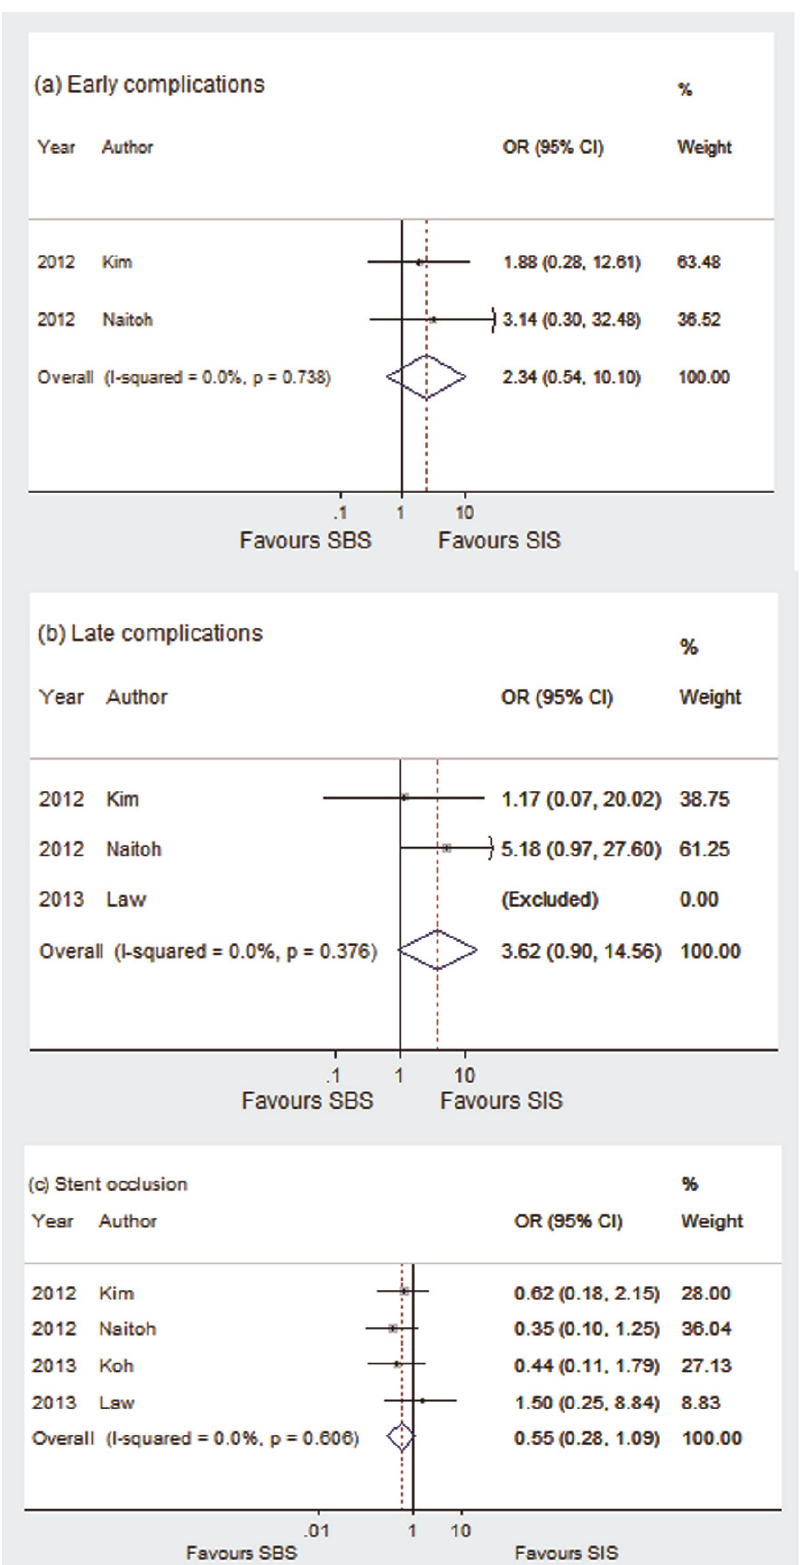
Figure 2 - A comparison of the early complications (a), late complications (b) and stent occlusions (c) between the SBS and SIS